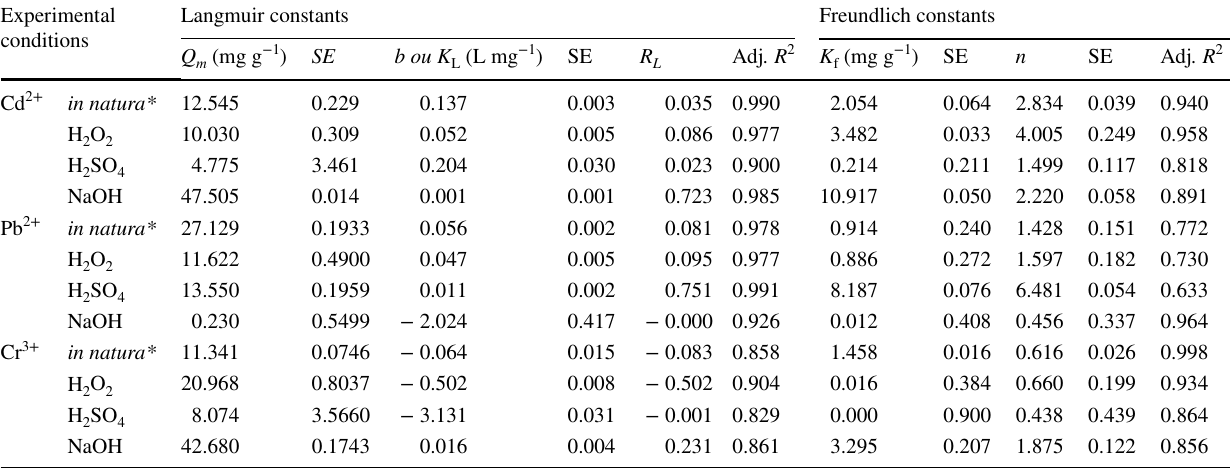
Table 8 Parameters of Langmuir and Freundlich adsorption parameters on the shell of cashews (CNS) in natura and modified with H and NaOH